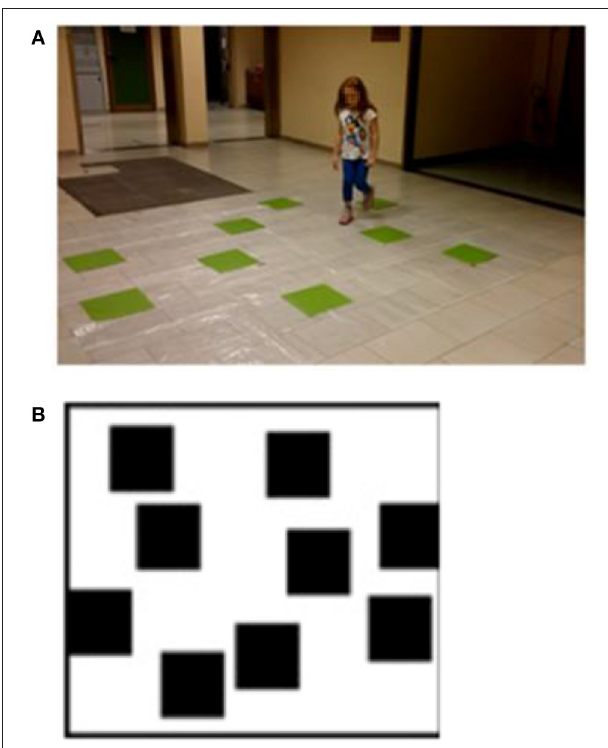
FIGURE 1 | (A) Walking Corsi test (WalCT). The WalCT was the apparatus used for measuring topographical memory. Nine black squares (30 × 30cm) were placed on a 2.50 × 3.00m white carpet. The scaled position and the relative spatial layout of the squares were the same as in the Corsi block-tapping test (CBT). (B) The outline map of the WalCT on which children had to draw the previously learned path. Written informed consent was obtained from the parents of the child represented in the figure for publication of this experiment. A copy of the written consent is available for review by the Editor-in-Chief of this